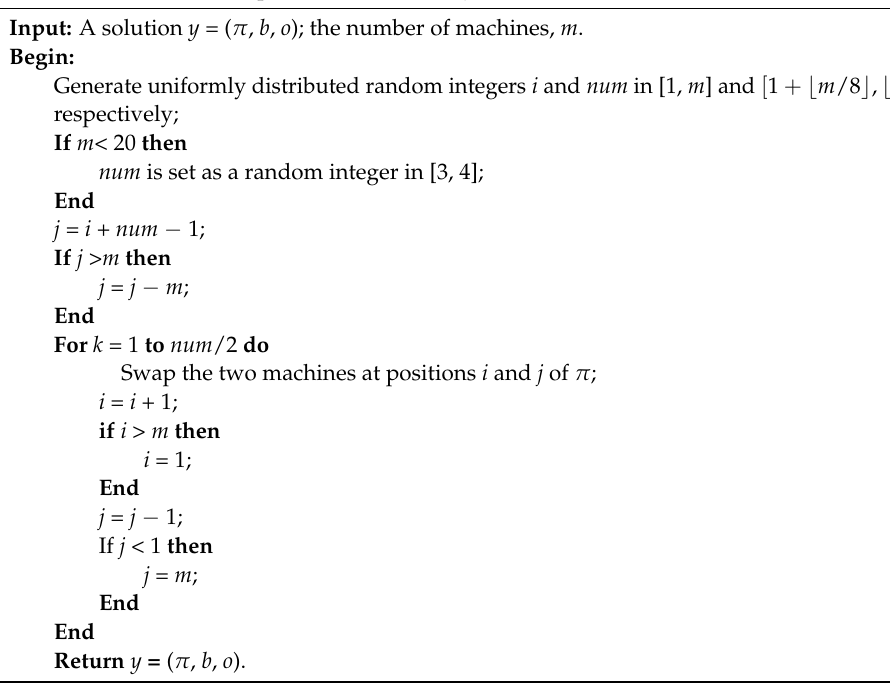
Algorithm 2. Inversion operation, Inversion ( y ).